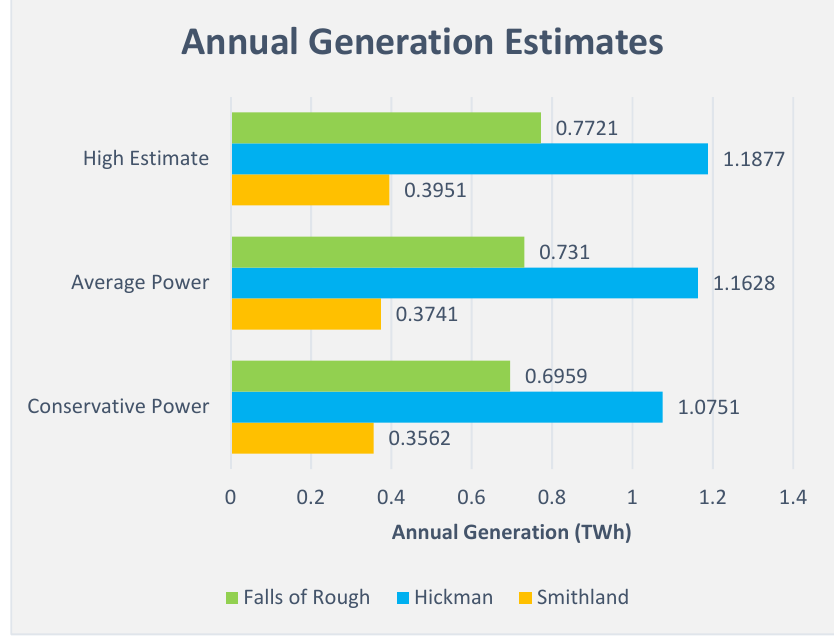
Figure 21 . Annual Power Generation Estimates [27,29].